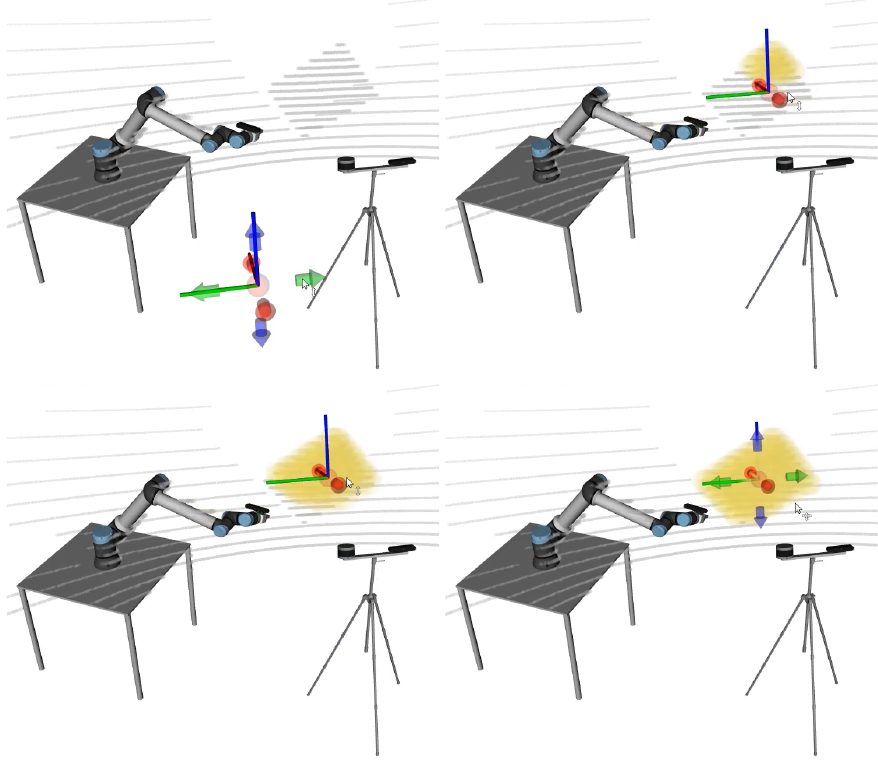
Figure 7. Semi-automatic LiDAR labelling procedure. In a span of about 5 s, the user drops the interactive marker close to the pattern, and the system starts tracking it. Yellow spheres indicate lidar measurements considered as pattern